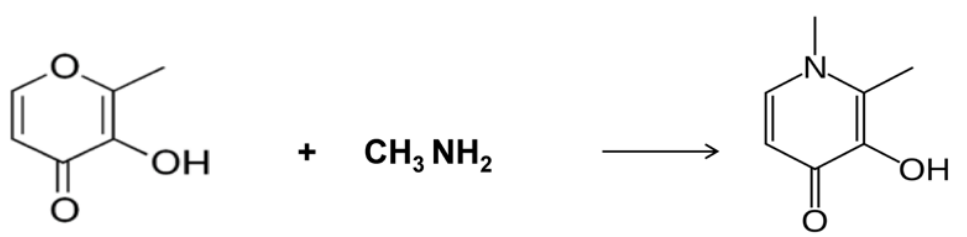
Figure 3. The simple one-step synthesis method of deferiprone (L1) from maltol and methylamine, which was invented in the Royal Free Hospital Medical School. The simple, inexpensive preparation of deferiprone (L1) led to the organization of clinical trials in London, UK, and multicenter clinical trials worldwide. The same synthetic method is currently used by generic pharmaceutical companies worldwide, and most importantly made deferiprone (L1) available to patients in developing countries, where thalassemia and other iron loading diseases are endemic (see